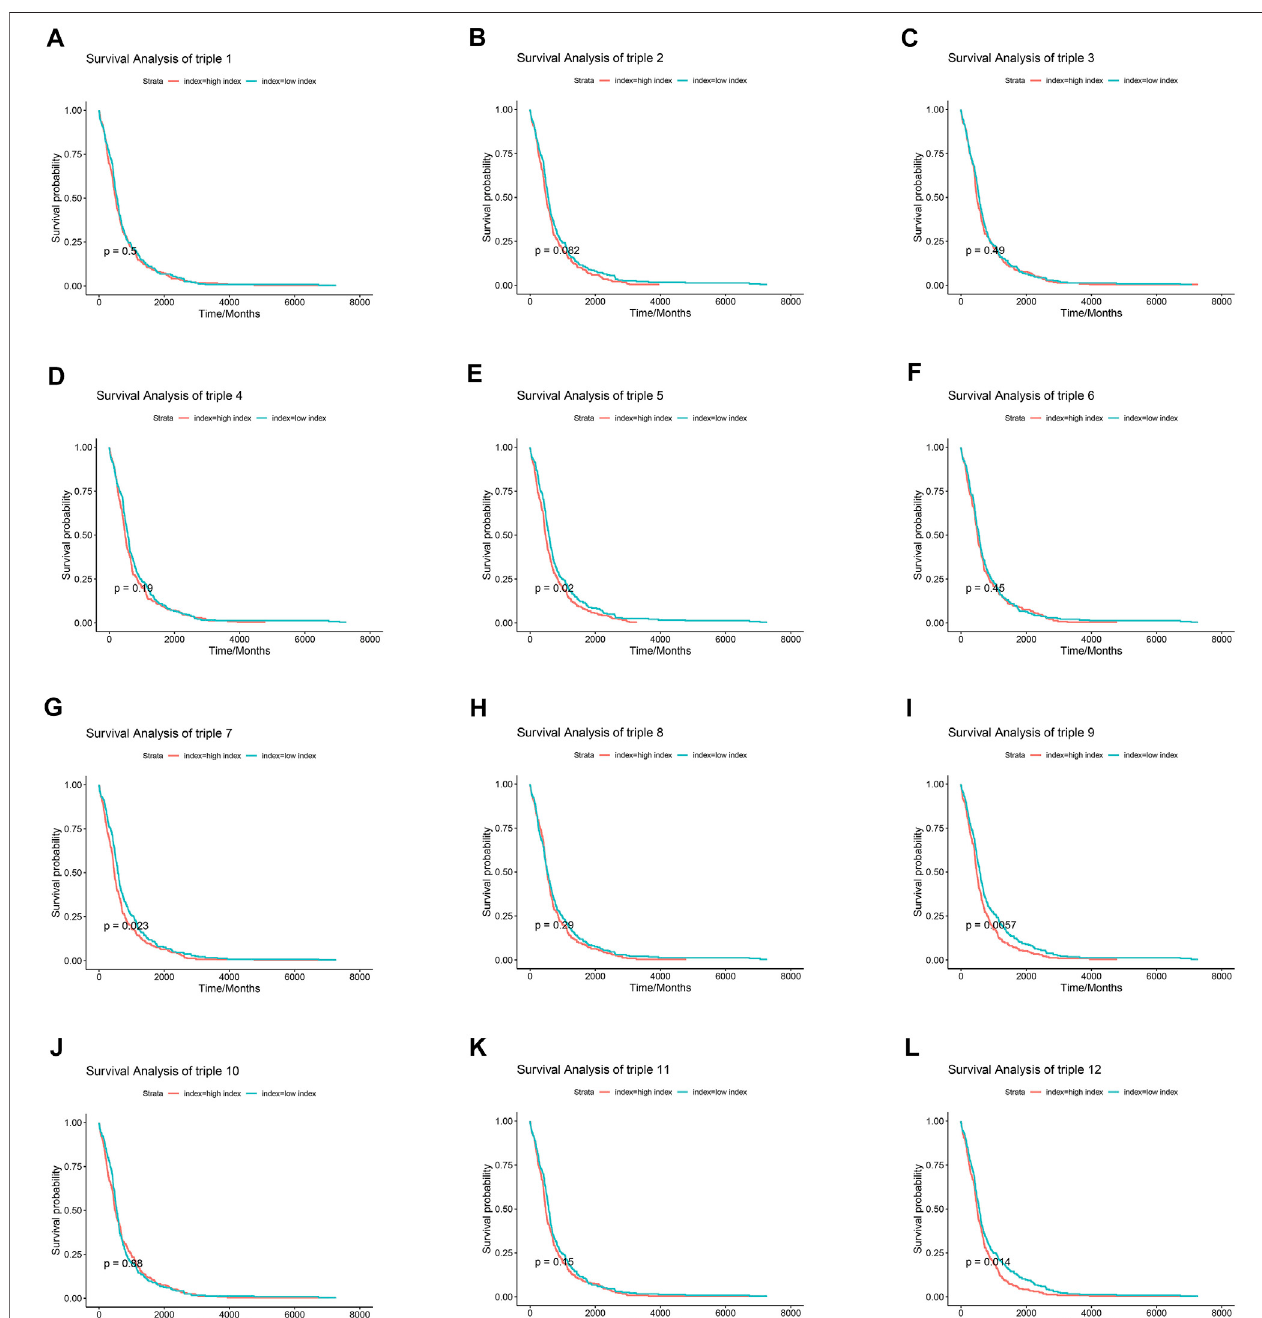
FIGURE 7 | Association between core lncRNA-miRNA-mRNA networks and progression-free interval (PFI) in patients with NSCLC. Red lines show the high- expression group; green lines, the low-expression group. The horizontal axis demonstrates the PFI time in years, and the vertical axis indicates the survival rate.